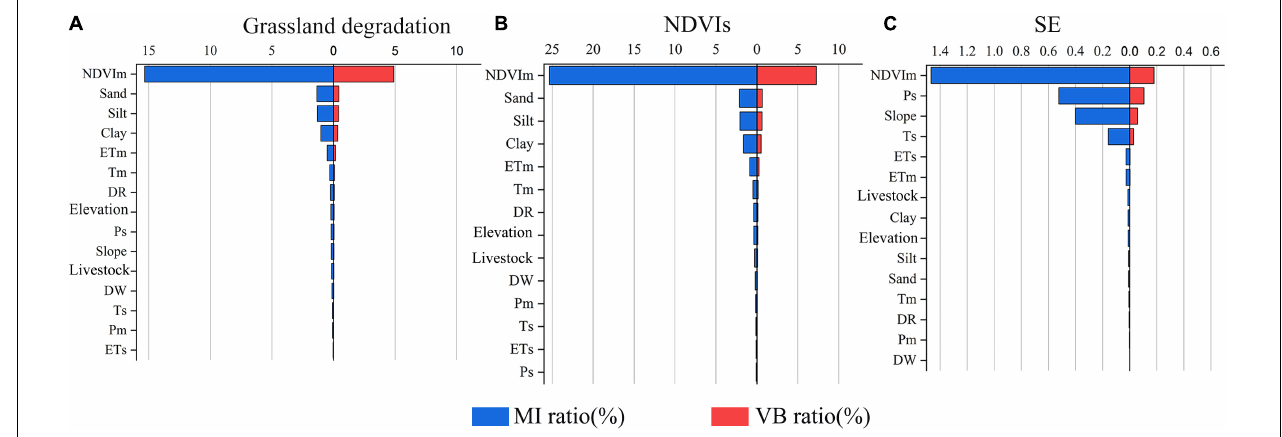
FIGURE 9 | Sensitivity analysis of all driving factors. (A) Grassland degradation. (B) NDVIs, slope of NDVI change. (C) SE, shrub-encroached grasslands.